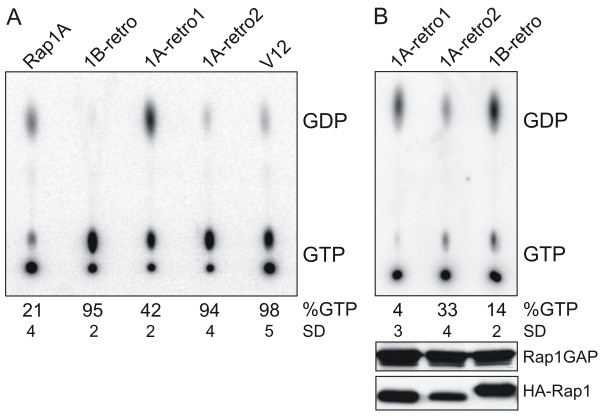
Determination of the GTP/GDP ratio bound to mRap1A-retro1, -retro2 and hRap1B-retro. A. Comparison of GTP binding between Rap1 retrogenes and Rap1V12. Cos-7 cells were transfected with 2 μg different Rap1 constructs as indicated, starved overnight, labelled with [32P] orthophosphate for 5 h. HA-Rap1 was immunoprecipitated with the 12CA5 anti-HA monoclonal antibody, and bound nucleotides were separated using thin layer chromatography, followed by PhosphorImager detection. SD, standard deviation. B. Rap retrogenes are sensitive to Rap1Gap. Cos7 cells were transfected with HA-Rap1Gap in combination with mRap1A-retro1, mRap1A-retro2 and hRap1B-retro. GDP and GTP, bound to transfected Rap1, was measured as indicated above. The bottom panels indicate the expression of HA-Rap1Gap and HA-Rap as determined by Western blotting using anti-HA as a probe.